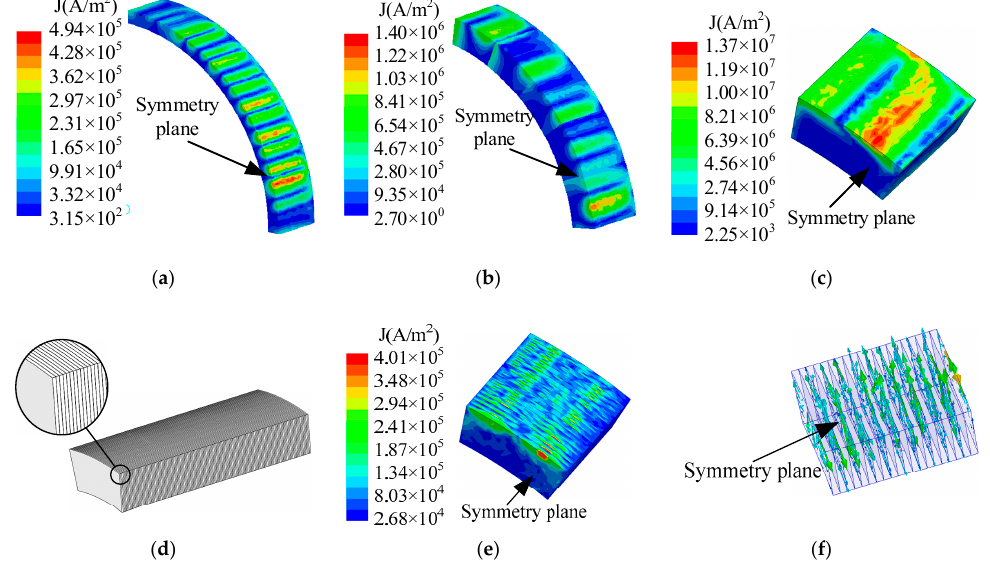
Figure 11. Distributions of eddy-current density of ( a ) sleeve; ( b ) magnets; ( c ) pole filler; ( d ) configuration of the metal-stack pole filler; distributions of ( e ) eddy-current density; ( f ) eddy-current vectors in the metal-stack pole filler. Table 6. Eddy-current losses of rotor with different pole fillers.